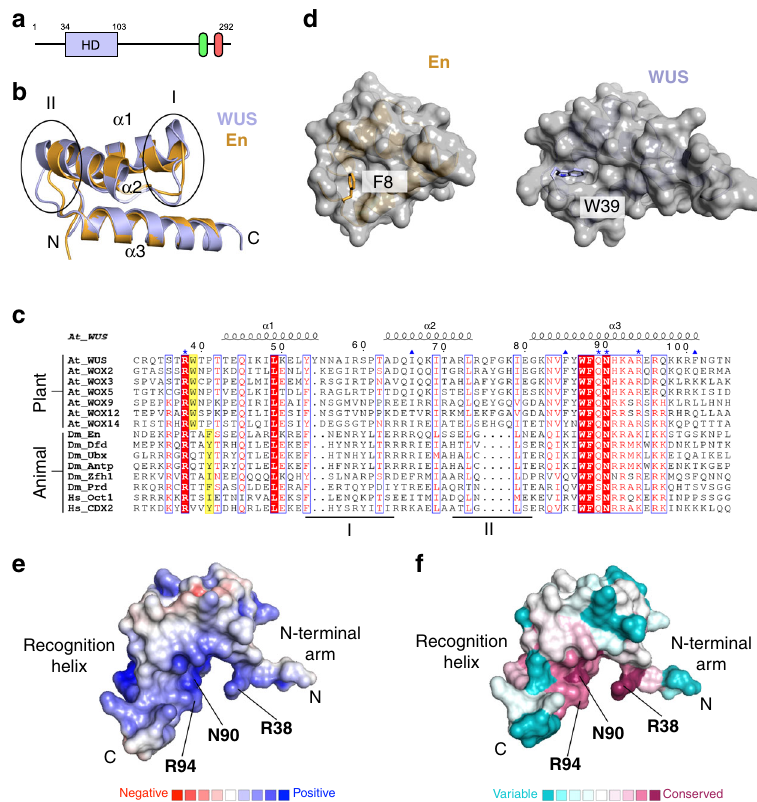
Fig. 1 Structure and conservation of the A. thaliana WUS-HD. a Domain organization of WUS from A. thaliana . WUS contains an N-terminal homeodomain (HD; light blue) and two short linear motifs at its C-terminus, namely the WUS-box (green) and the EAR motif (red), respectively. The domain boundaries are given in residue numbers. b Superimposition of WUS-HD structure (light blue) with HD from En (orange, PDB 3HDD 23 ), illustrating the characteristic three-helix bundle fold of HDs. Encircled are loop regions I and II of WUS, which highlight structural differences compared to classical HDs. c Multiple sequence alignment of representative HDs from plants and animals. The sequences of Arabidopsis thaliana ( At ), Drosophila melanogaster ( Dm ) and Homo sapiens ( Hs ) were aligned using Clustal Omega and visualized with ESPRIPT. Numbering and secondary structure assignment is according to A. thaliana WUS. Loop regions I and II are depicted below the sequences by black lines and the anchoring residue of the N-terminal arm is illustrated by yellow boxes. Highly conserved residues are highlighted (red boxes) and residues making direct DNA-base contact (blue asterisk) and residues involved in the dimer interface (blue up-pointing triangle) are indicated. d Comparison of different anchoring mechanisms of the N-terminal arm for En (orange, PDB 3HDD 23 ) and WUS (light blue). Surface representation of the HDs (gray) highlighting the hydrophobic pocket formed by helices α 1 and α 2. Amino acids responsible for fi xing the N-terminal arm are shown as sticks. e Electrostatic surface potential (red: negative, blue: positive, contoured at ±5 k B T ) of WUS- HD. f ConSurf analysis showing the degree of amino acid conservation (magenta: conserved, cyan: variable) mapped on to the surface of WUS-HD. Highly conserved amino acids typically involved in DNA base interactions are